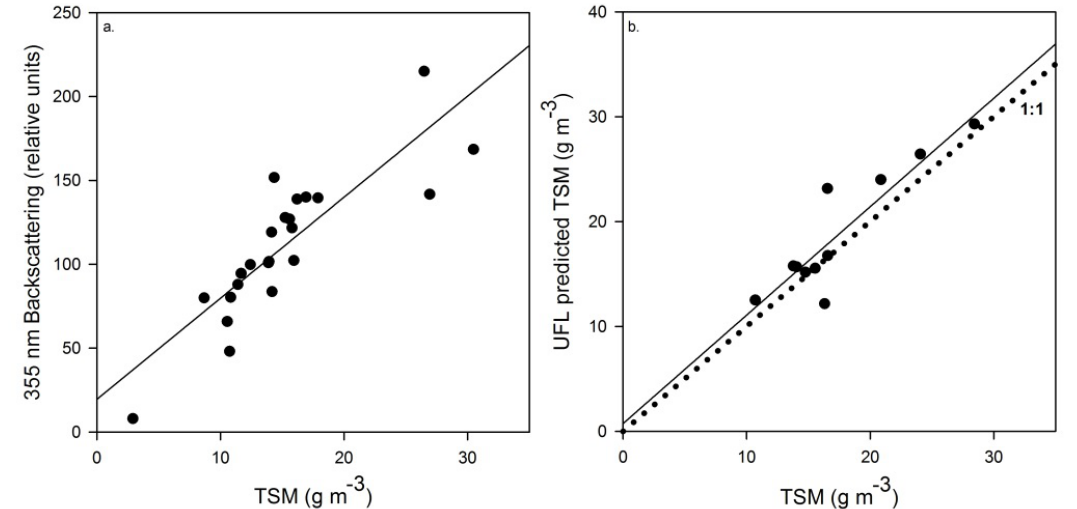
Figure 7. Field campaign specific ( a ) calibration (TSM = 6.02 × UFL p < 0.001) and ( b ) validation of UFL TSM measurements (R = 0.90; p < 0.001; RMSE = 2.80 g·m − 3 ). Solid line is regression trend line; dotted line is 1:1.